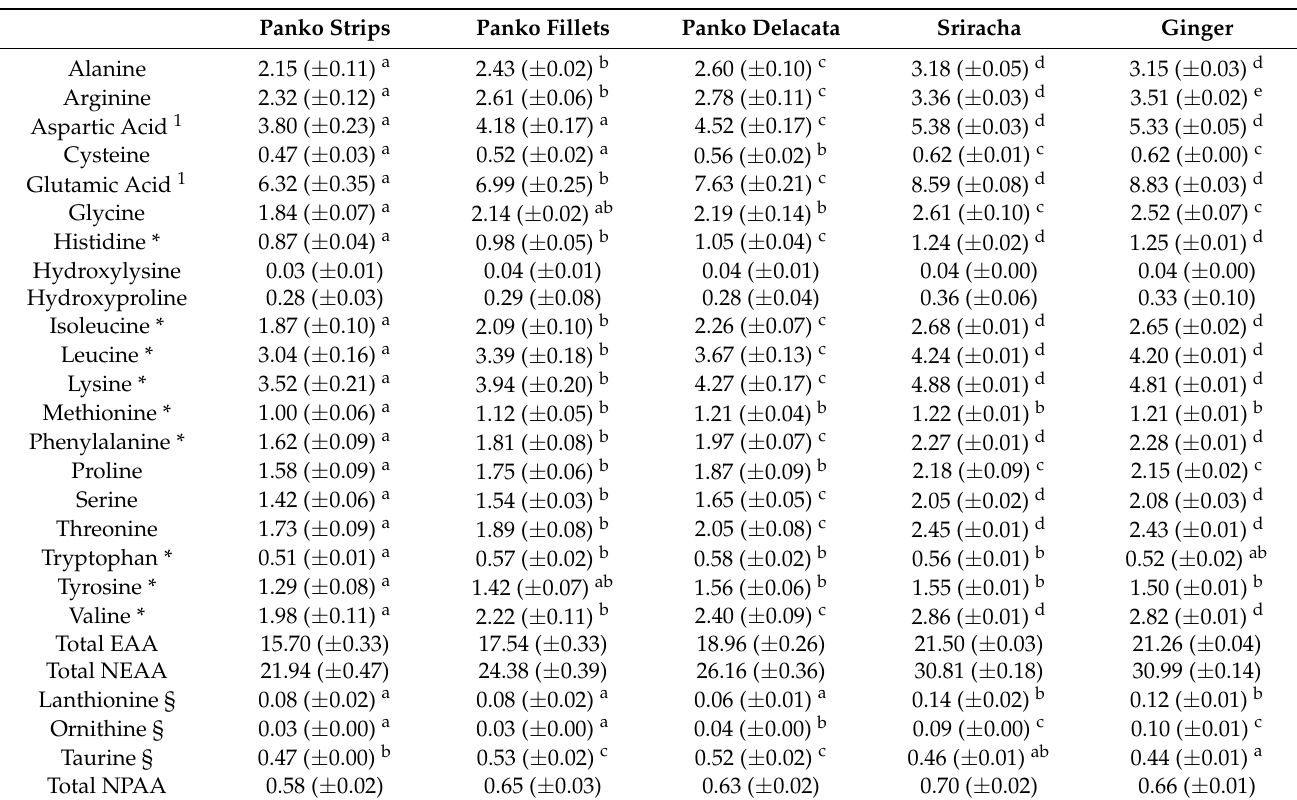
Table 4. Amino acid